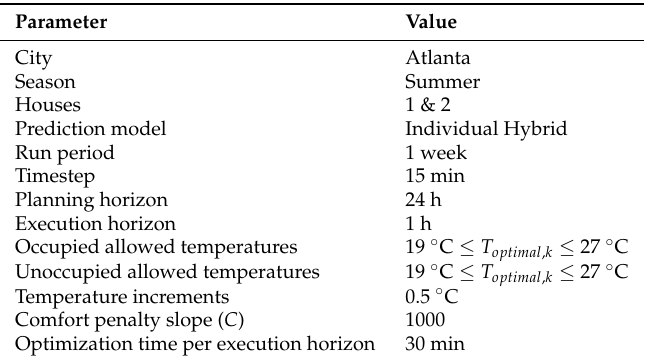
Table 13. Settings used for MPC optimization in Case 2A.